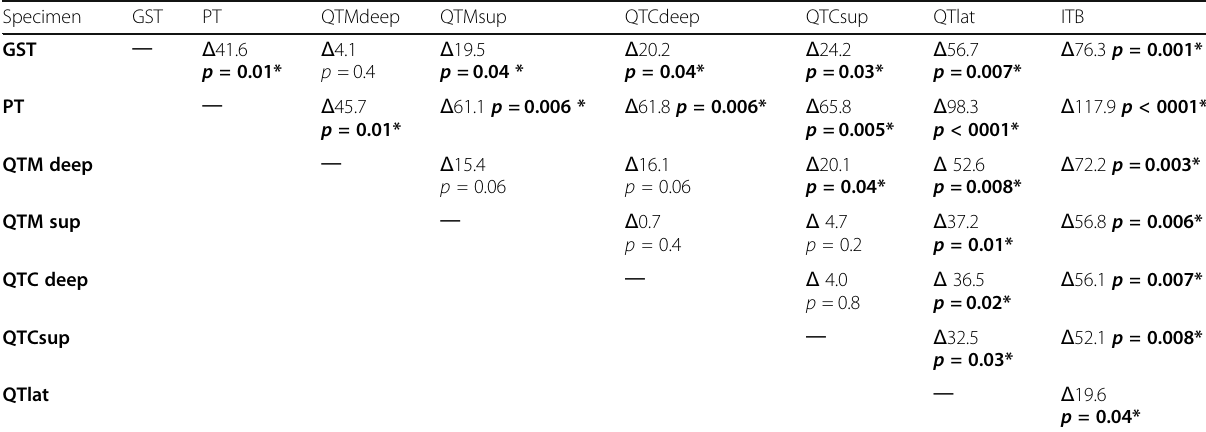
Table 4 Comparison between specimens in terms of Ultimate Stress (Mean values) Specimen GST PT QTMdeep QTMsup ─ Δ 41.6 p = 0.01*